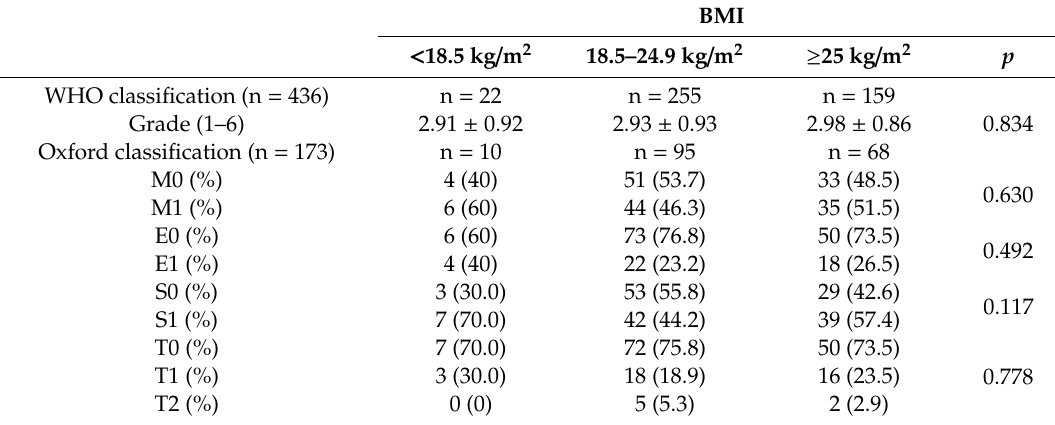
Table 3. The distribution of histological classifications according to the three BMI